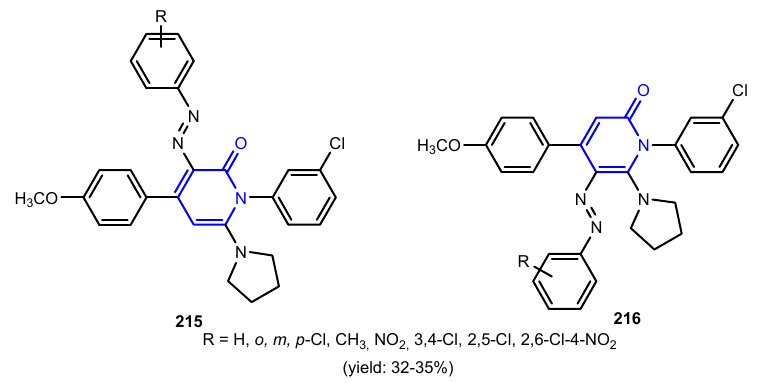
Figure 21. Structures of compounds 215 and 216.